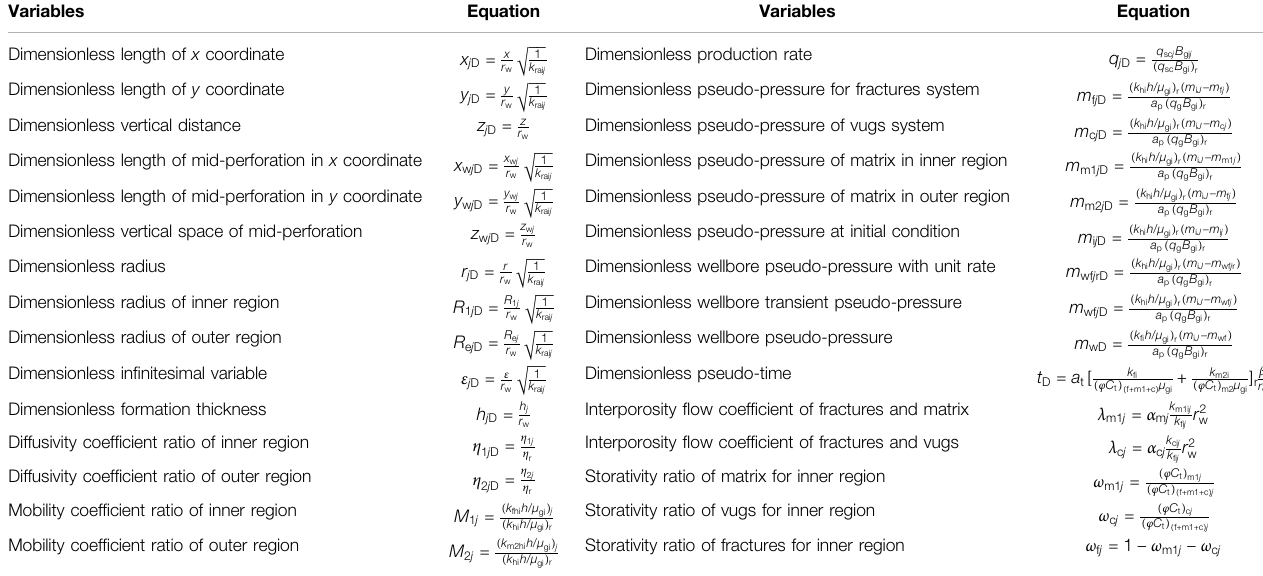
TABLE 1 | De fi nition of dimensionless variables for layer j . Variables Equation Variables Equation Dimensionless length of x